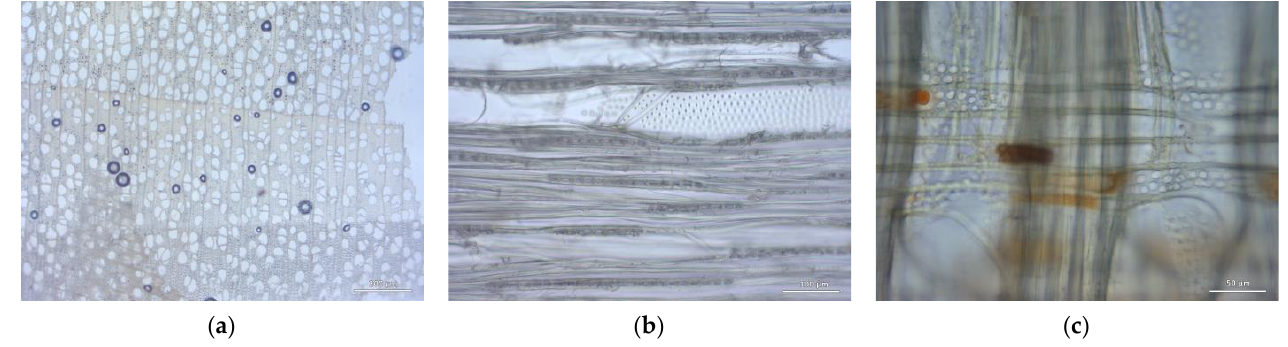
Figure 8. Characteristic sections identified as belonging to the Populus genus: ( a ) Cross-section of sample BU1; ( b ) Tangential section of sample CA2; ( c ) Radial section of sample PA1.